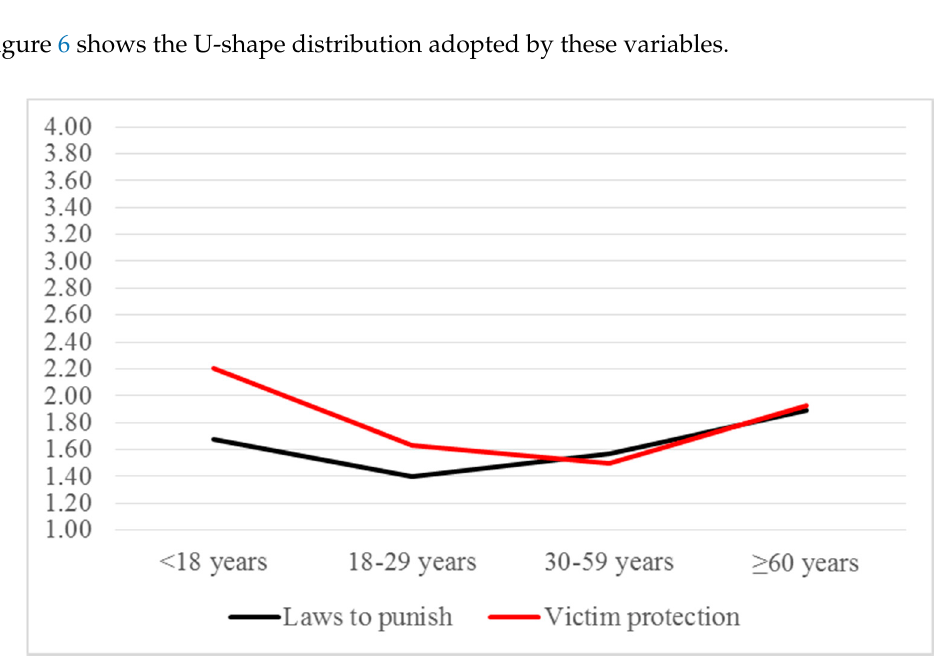
Table 8. Mean differences in explicit and implicit measures by gender ( ≤ 29 years).